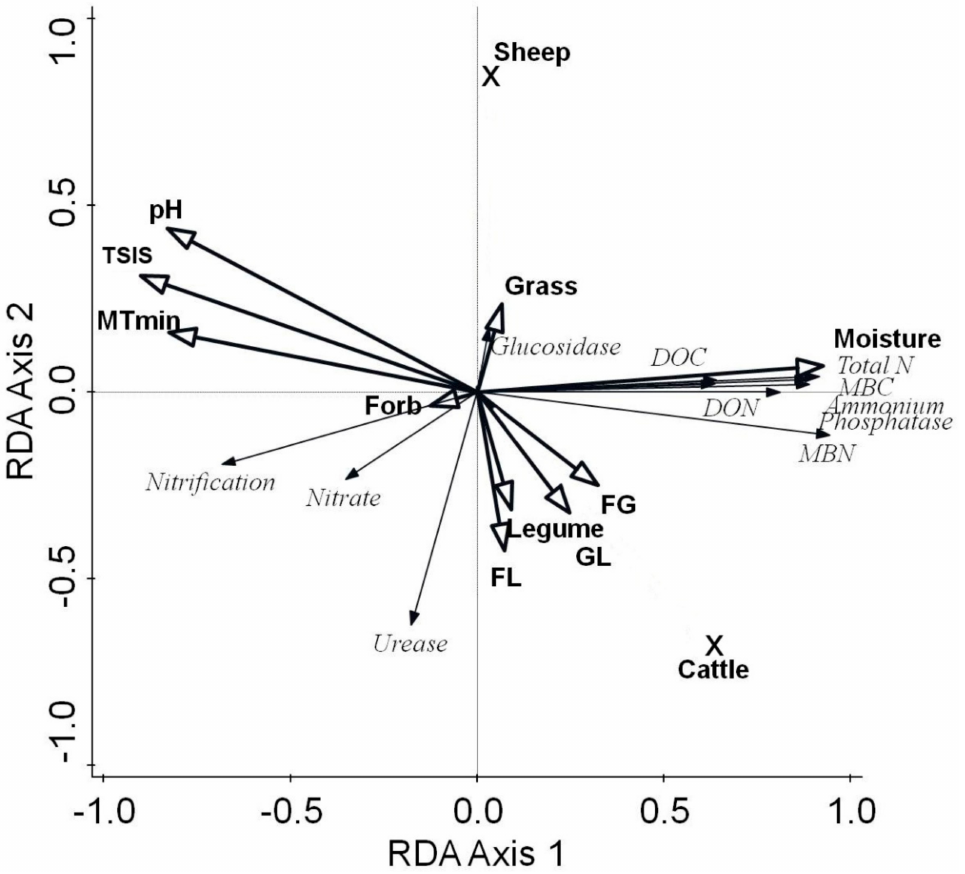
Figure 3. RDA ordination diagram showing the relationship between soil activity and fertility, and selected environmental factors in six grassland sites in the northern part of the Iberian Peninsula. Bold arrows with an empty arrowhead represent explanatory variables: environmental (climatic, management and soil): Temperature seasonality index of Sebasti à (TSIS); mean minimum air temperature (MTmin) and plant functional diversity variables: FG (pairwise interactions between forbs and grasses); FL (pairwise interactions between forbs and legumes); GL (pairwise interactions between grasses and legumes). Thinner arrows and in italics represent soil activity and fertility response variables: dissolved organic carbon (DOC); dissolved organic nitrogen (DON); total nitrogen (Total N), microbial biomass carbon (MBC); microbial biomass nitrogen (MBN). The first (x) and second (y) axes explained 84.75% and 0.54% of the total variance, respectively. The adjusted explained variation (R adj. ) of the RDA model was 81.4%. The arrow length and direction correspond to the variance that can be explained by the environmental (climatic, soil and management) variables. The direction of an arrow indicates an increasing magnitude of the variable. The perpendicular distance between orders and environmental variable axes in the plot reflects their correlations. The smaller the distance, the stronger the correlation. Grazer type is a categorical variable so we removed the arrow and substituted it by an